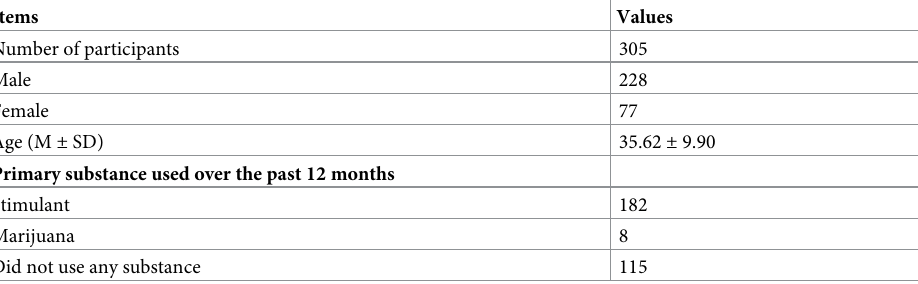
Table 1. Participants’